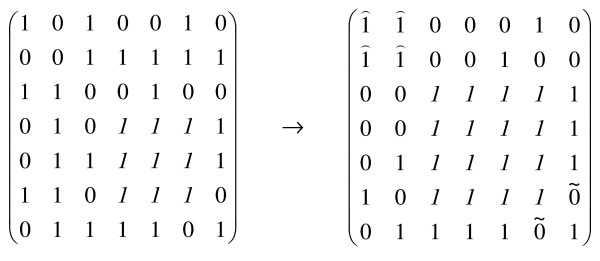
Example of an adjacency matrix for 7 nodes. Permuting rows and columns 2 and 3 yields a better clustering with two clusters, indicated by hats and italic digits, respectively. Flipping "0" entries on the bottom right of the matrix (marked with tildes) further extends the cluster with italic digits.